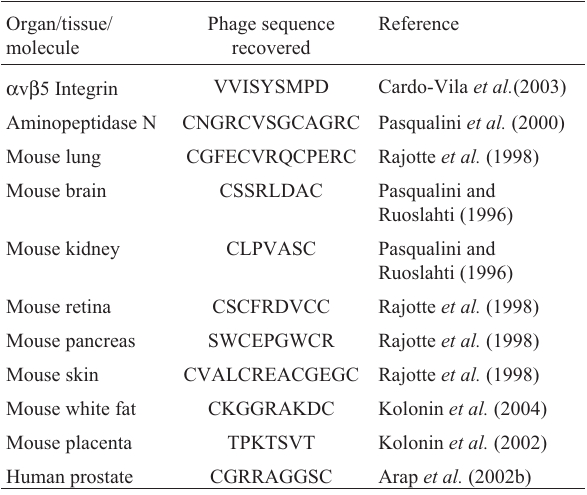
Table 1 - Peptides with potential therapeutic implications identified by phage display. Organ/tissue/